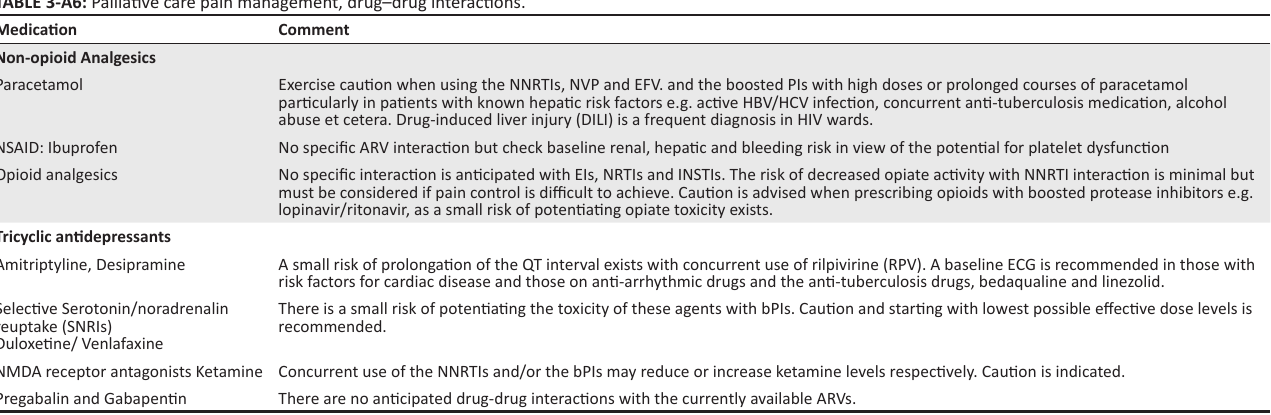
TABLE 3-A6: Palliative care pain management, drug–drug interactions. Medication Comment